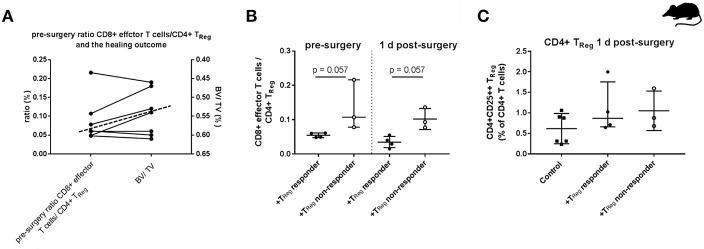
Individual effector/regulatory T cell ratio pre-osteotomy determines the healing outcome in mice. (A) Mice having a lower pre-surgery CD8+ TEFF to CD4+ TReg ratio (left y-axis) showed a higher BV/TV (right y-axis, axis is reversed for a clearer depiction). Dashed line indicates the cut off between the +TReg responder (below the dashed line) and the +TReg non-responder (above the dashed line). (B) Adoptive CD4+ TReg transfer did not reshape the unfavorable CD8+ TEFF/CD4+ TReg ratio. (C) Engraftment of CD4+CD25++ T cells 1 d post-surgery is elevated in both, the +TReg responder (n = 4) and +TReg non-responder (n = 3) in comparison to the control group (n = 6). 45BV, total bone volume; TV, total callus volume; BV/TV, ratio of BV to TV; Mann–Whitney U-test.